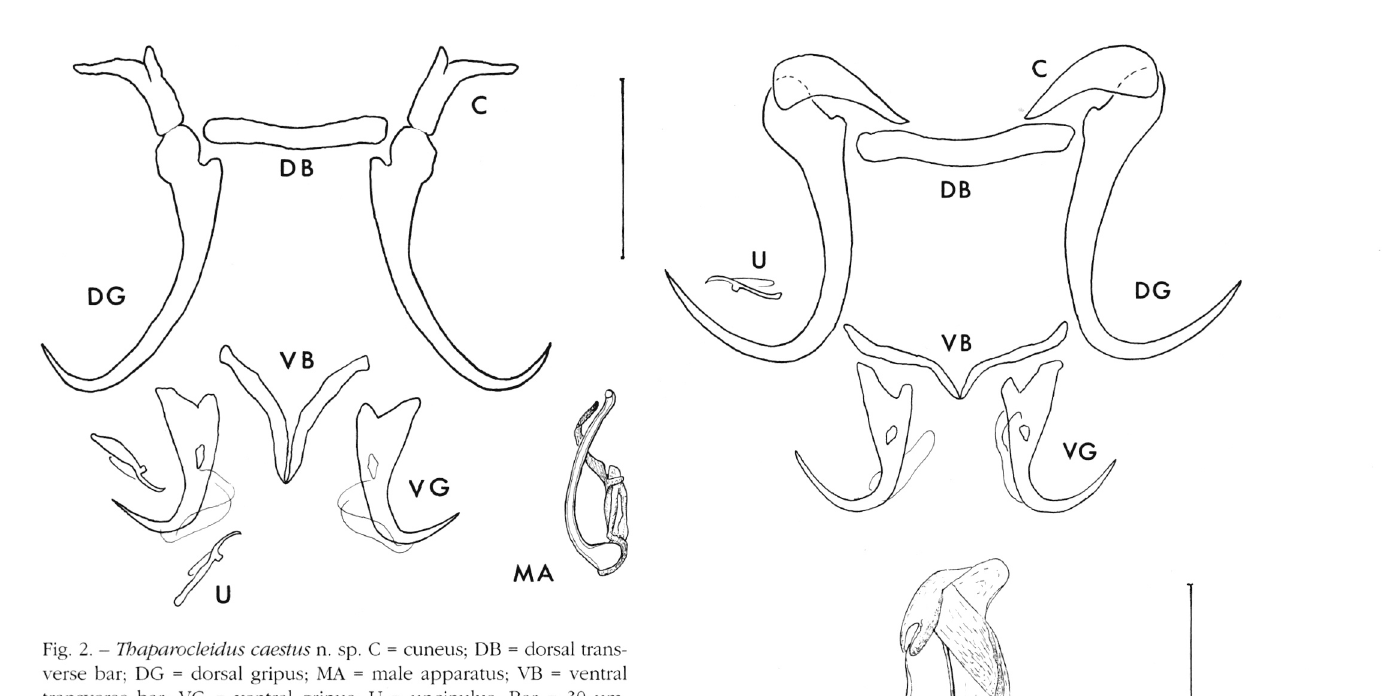
Fig. 2. - Thaparocleidus caestus n. sp. C = cuneus; DB = dorsal trans­ verse bar; DG = dorsal gripus; MA = male apparatus; VB = ventral transverse bar; VG = ventral gripus; U = uncinulus. Bar = 30 µm.